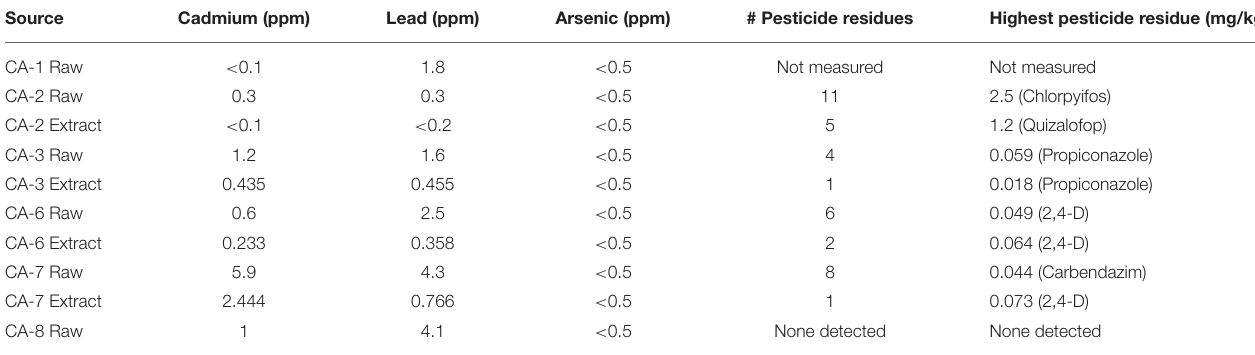
TABLE 1 | Heavy metal and pesticide content of five CA trade samples acquired for possible use in preparing CAP, and their water extracts.